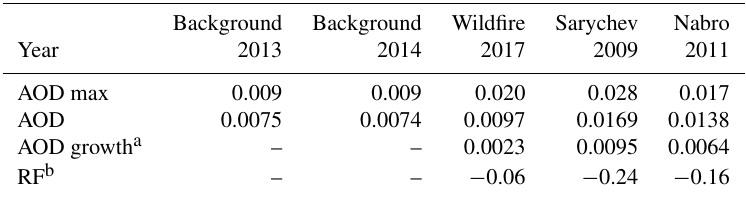
Table 1. Maximum and yearly average stratospheric AOD during background conditions as well as during 1 year after the fire and after the two volcanic eruptions in Fig.